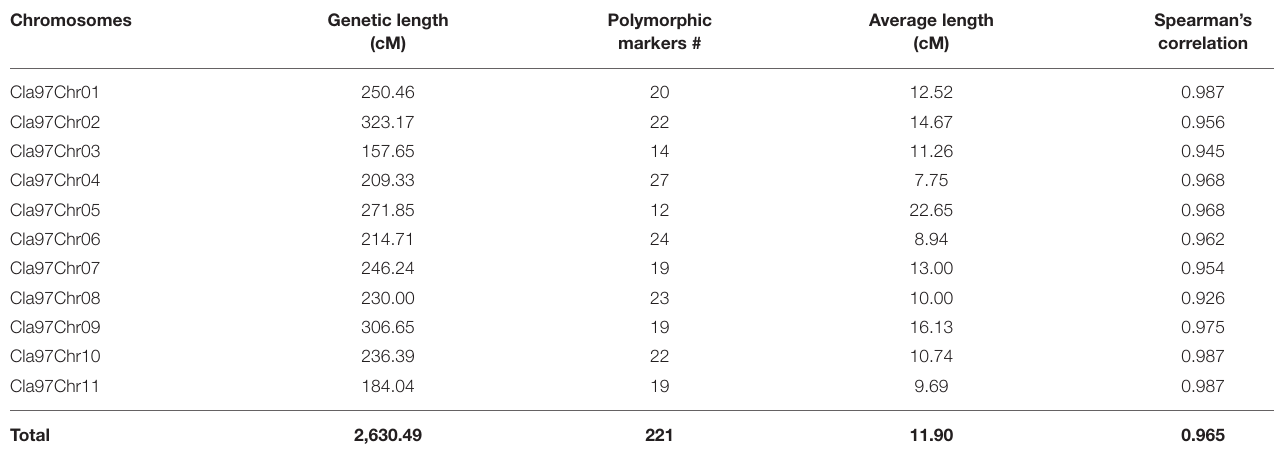
TABLE 1 | Summary of markers distributions across the developed genetic linkage map of watermelon.